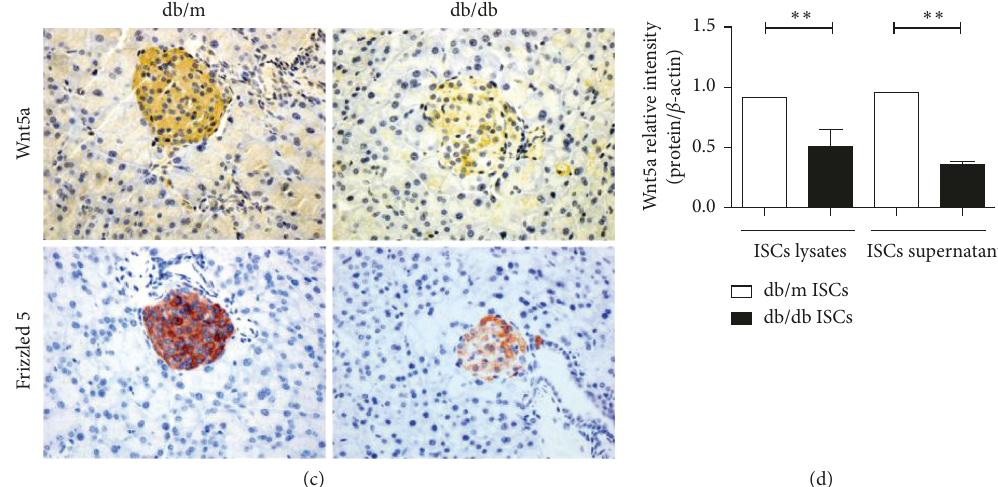
Figure 1: The effects of different ISC profiles on islet insulin secretory function and Wnt5a content and release by ISCs. (a) Compared with coculture with ISCs isolated from normoglycemic db/m mice, coculture of islets with ISCs isolation from db/db mice significantly reduced insulin secretion in vitro. All data were expressed as the mean ± SE ( n � 3); ∗ P < 0 . 05; ∗∗ P < 0 . 01; normoglycemic db/m ISCs vs hyper- glycaemic db/db ISCs. (b) Protein levels of Wnt5a were increased in control db/m ISCs than db/db ISCs. All data were expressed as the means ± SE ( n � 3); ∗ P < 0 . 05; ∗∗ P < 0 . 01; normoglycemic db/m ISCs compared with hyperglycaemic db/db ISCs. (c) Wax-embedded sections of db/m and db/db mouse pancreases showing the expression of Wnt5a and Frizzled 5 as revealed by immunohistochemistry. Scale bar � 50 μ m. (d) Protein levels of Wnt5a were increased in db/m ISCs lysates and supernatant than in the db/db ISCs. All data were expressed as the means ± SE ( n � 3); ∗ P < 0 . 05; ∗∗ P < 0 . 01; normoglycemic db/m ISCs compared with hyperglycaemic db/db ISCs.